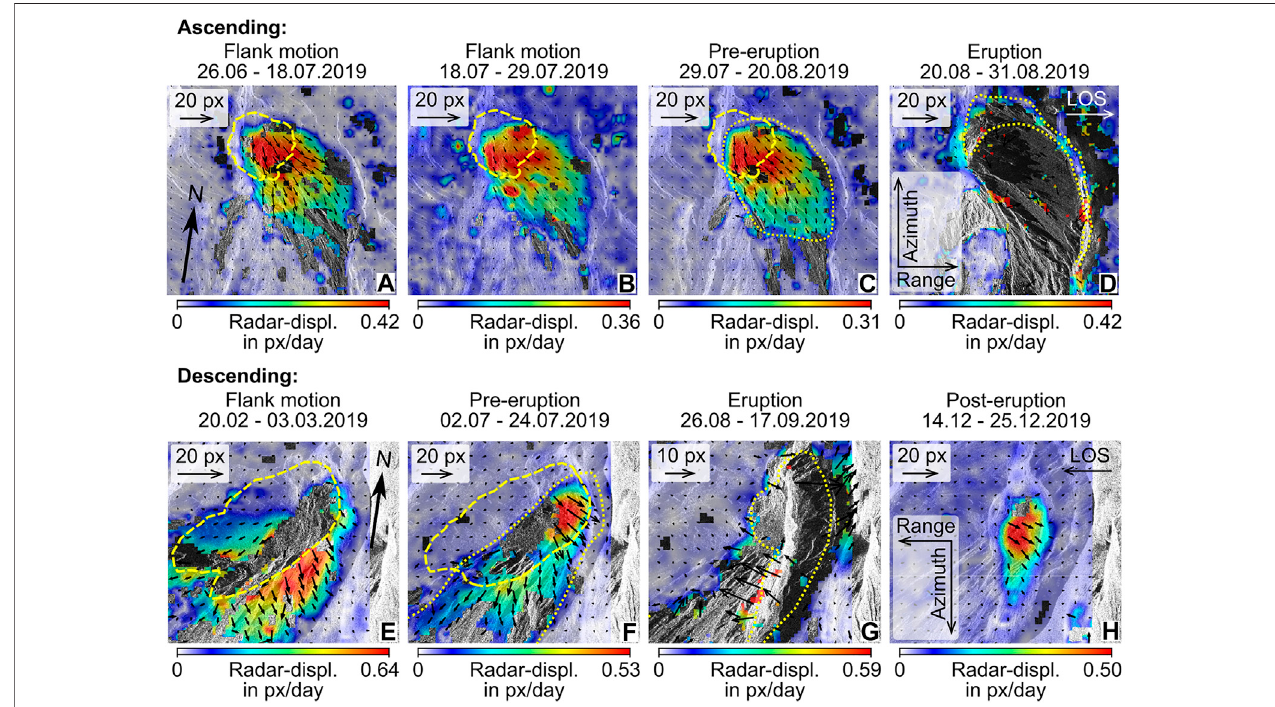
FIGURE8| SelectedPIVtracking mapsfromtheTSXdatainascending (A – D) anddescending (E – H) orbits. Theyellowdashed linesoutlinethenewlavalobe;the yellow dotted lines indicate the outlines of motion before the partial destruction of the dome (C,F) and the shape of the area affected by destruction (D,G) . The approximate scales are 0.59 px/m for the ascending view and 0.73 px/m for the descending view, but these scales should be used with caution (see the Data and Methods ). The fulltimeseries ofthe tracking results can be found in the supplementary material ( Supplementary Figure S3 ).For the base images, please refer to Figure 7 for the descending data and to Supplementary Figure S2 for the ascending